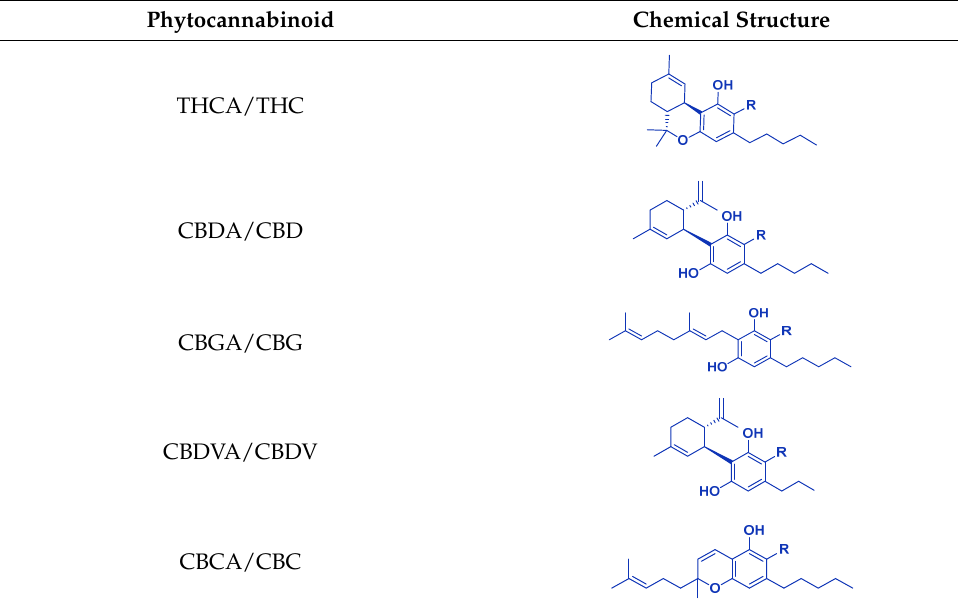
Table 1. Representative structures of the relevant phytocannabinoids.